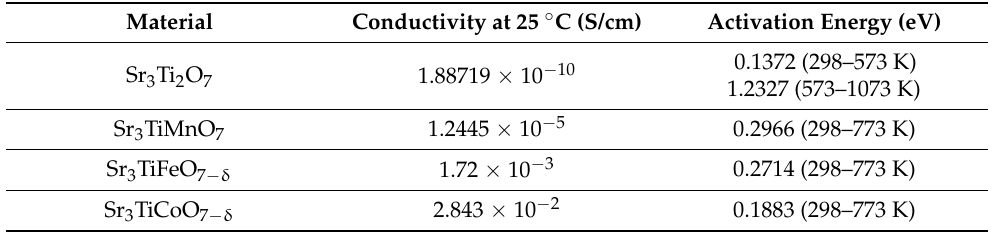
Table 6. Room temperature electrical conductivities and activation